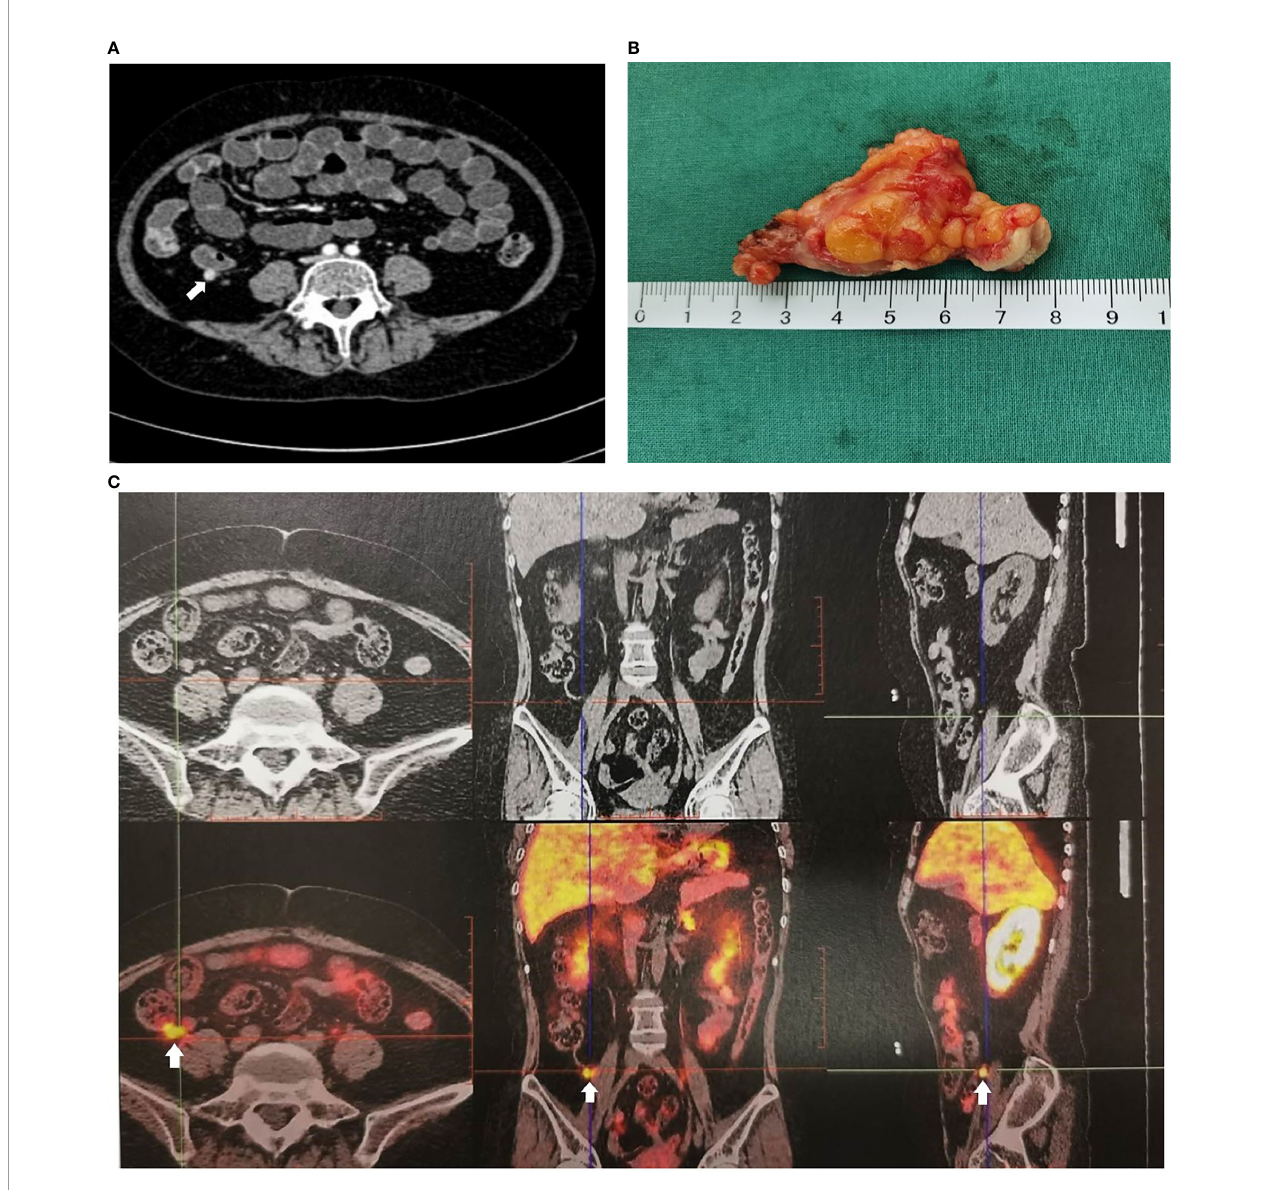
FIGURE 1 | Imaging examination of appendiceal mass. (A) Appendiceal mass showed by contrast enhanced CT reconstruction of the small intestine. (B) Appendiceal mass. (C) Appendiceal mass showed by 68